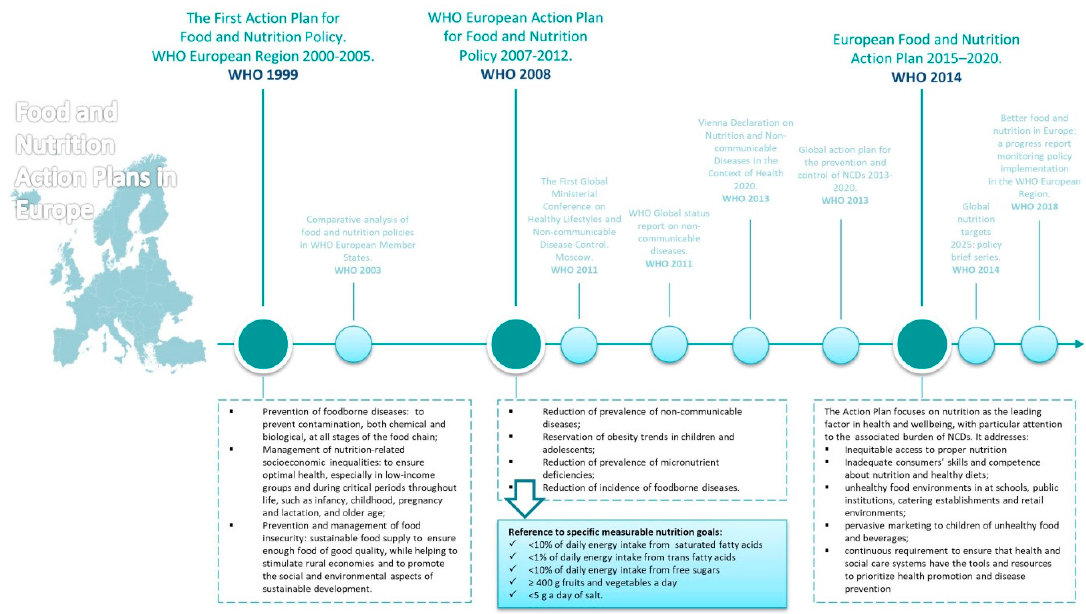
Figure1. PublichealthandnutritionpoliciesinEurope. Abbreviations: NCD(non-communicablediseases); Figure 1. Public health and nutrition policies in Europe. Abbreviations: NCD (non-communicable WHO (World Health Organization). Source of information included in figure: diseases); WHO (World Health Organization). Source of information included in figure: [8–15]